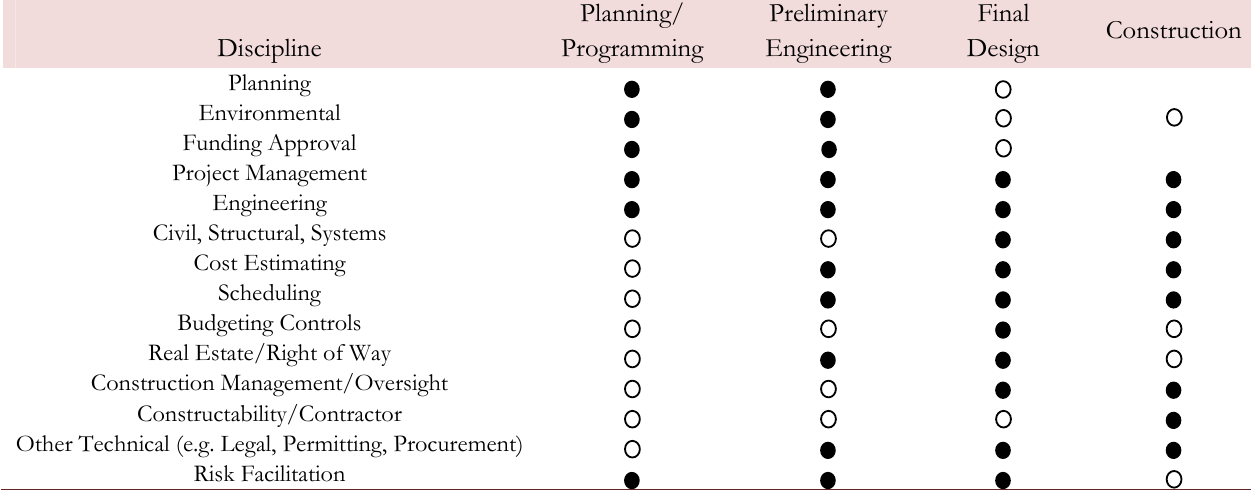
Table 1: Key expertise for risk analysis by project phase (Adapted from [32]). Highly desirable; Desirable but optional depending upon